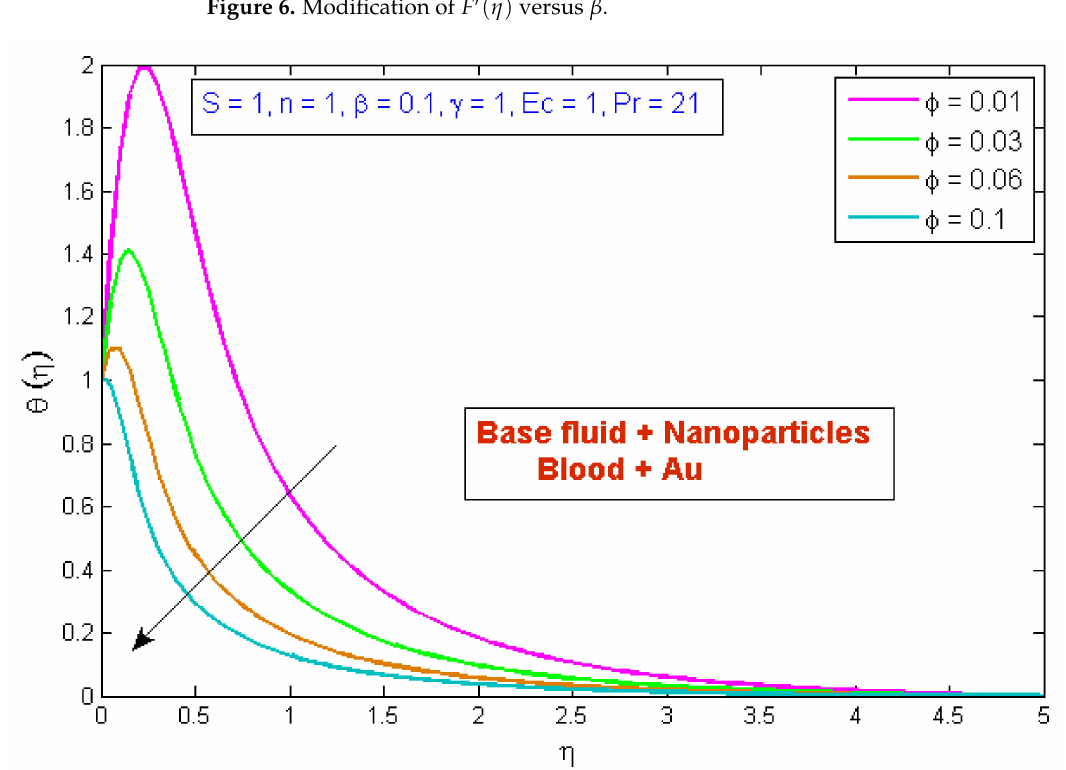
Figure 7. Modification of θ ( η ) versus φ